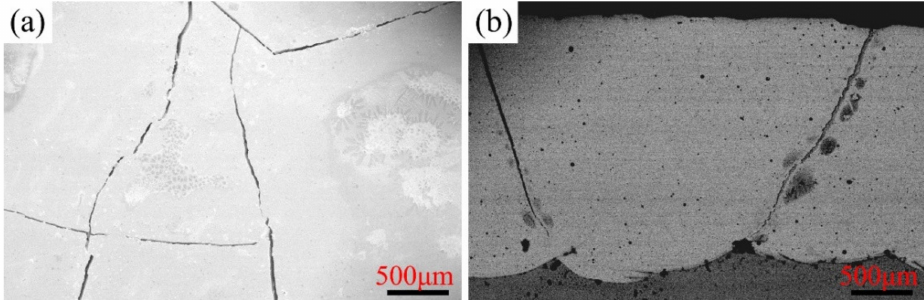
Figure 2. SEM morphology of C5 laser-cladding coating: ( a ) surface and ( b )